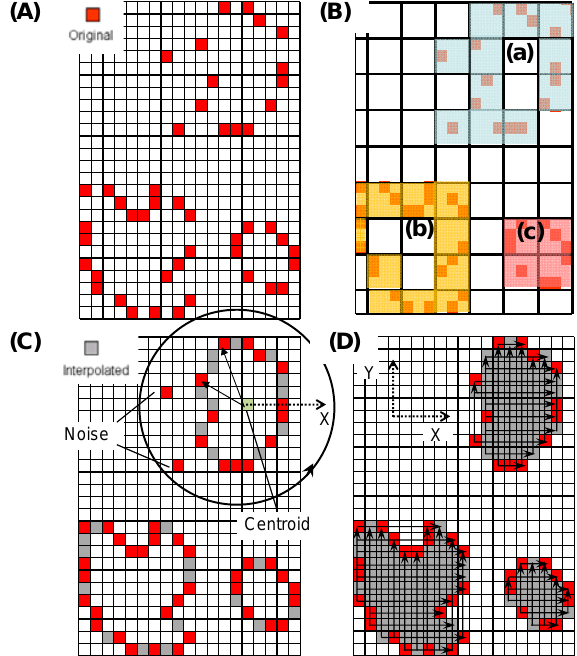
Figure 1: Generation of the exterior surface contours of the stem and large branches. (A) Original voxels within a horizontal layer obtained by conversion of the lidar data points. (B) A grid was overlaid on a one-voxel-thick horizontal layer, and voxel sets (a), (b), and (c), corresponding to the contours of the stem and each large branch are identified by connecting cells using a neighbor-tracing algorithm. (C) Contours of the stem and of large branches are filled by interpolating voxels (light gray) between the original voxels. (D) Interior voxels are identified and filled by scanning in the x and y directions from voxels on the contour (Hosoi et al.,